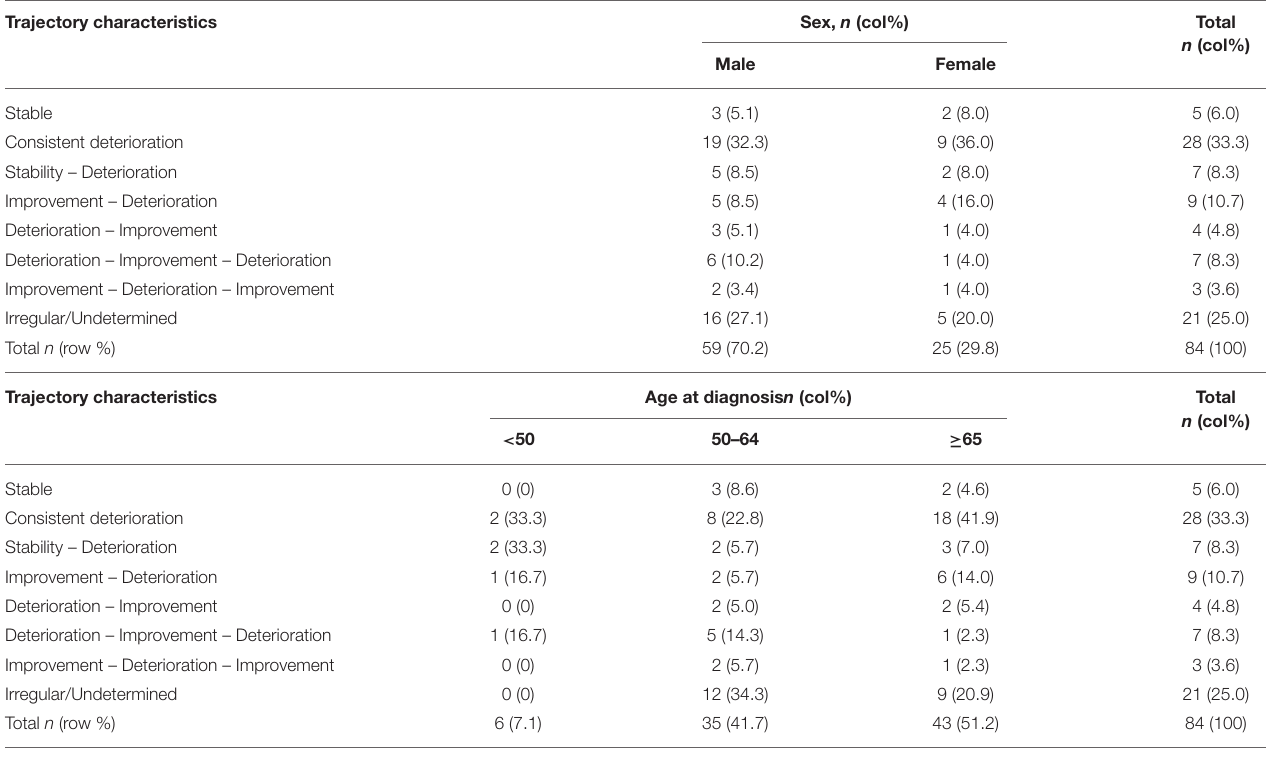
TABLE 3 | Summary of the trajectory types in relation to sex and age of onset of Parkinson’s disease. Trajectory characteristics